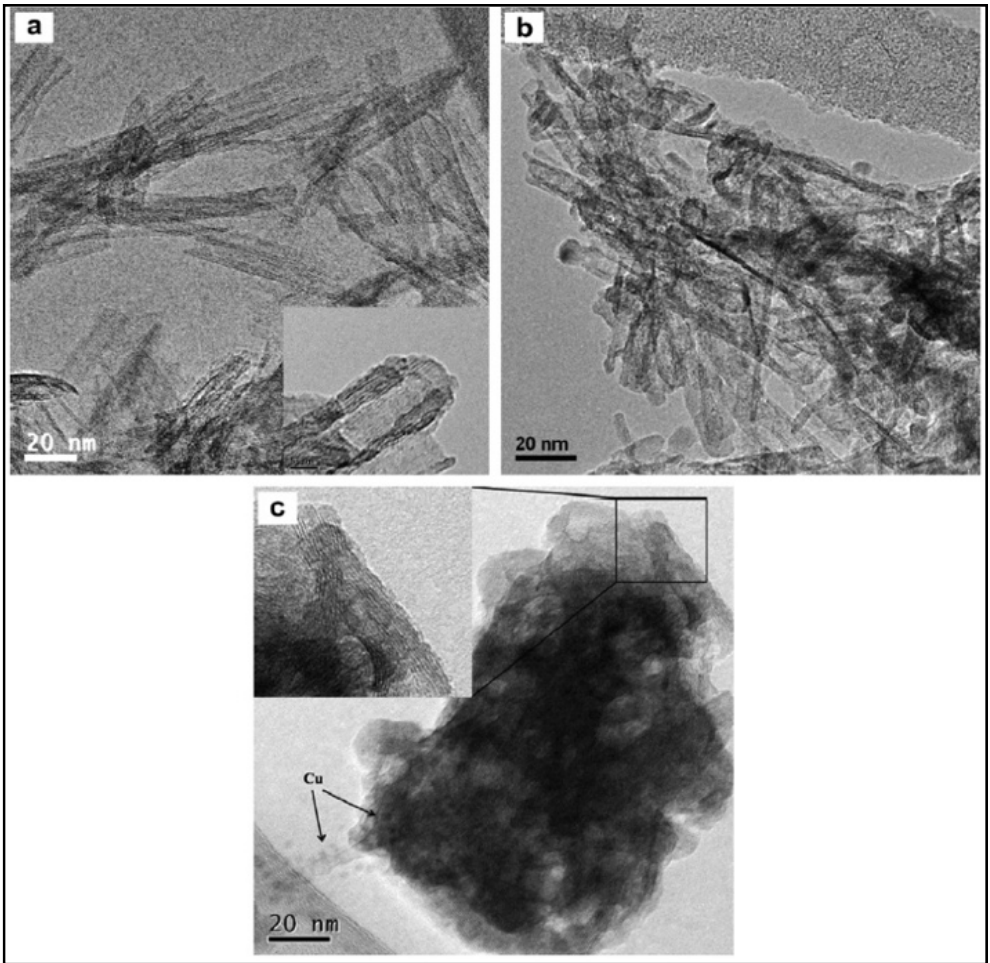
Figure 21. HRTEM images of photocatalysts: TNT showing a multilayered nanotubular structure ( a ); CuO incorporated onto TNT by adsorption–calcination ( b ); and CuO incorporated by wet-impregation ( c ). The inset in c shows a higher magnification of the aggregation of the nanotubes. Reproduced with permission from reference [139].